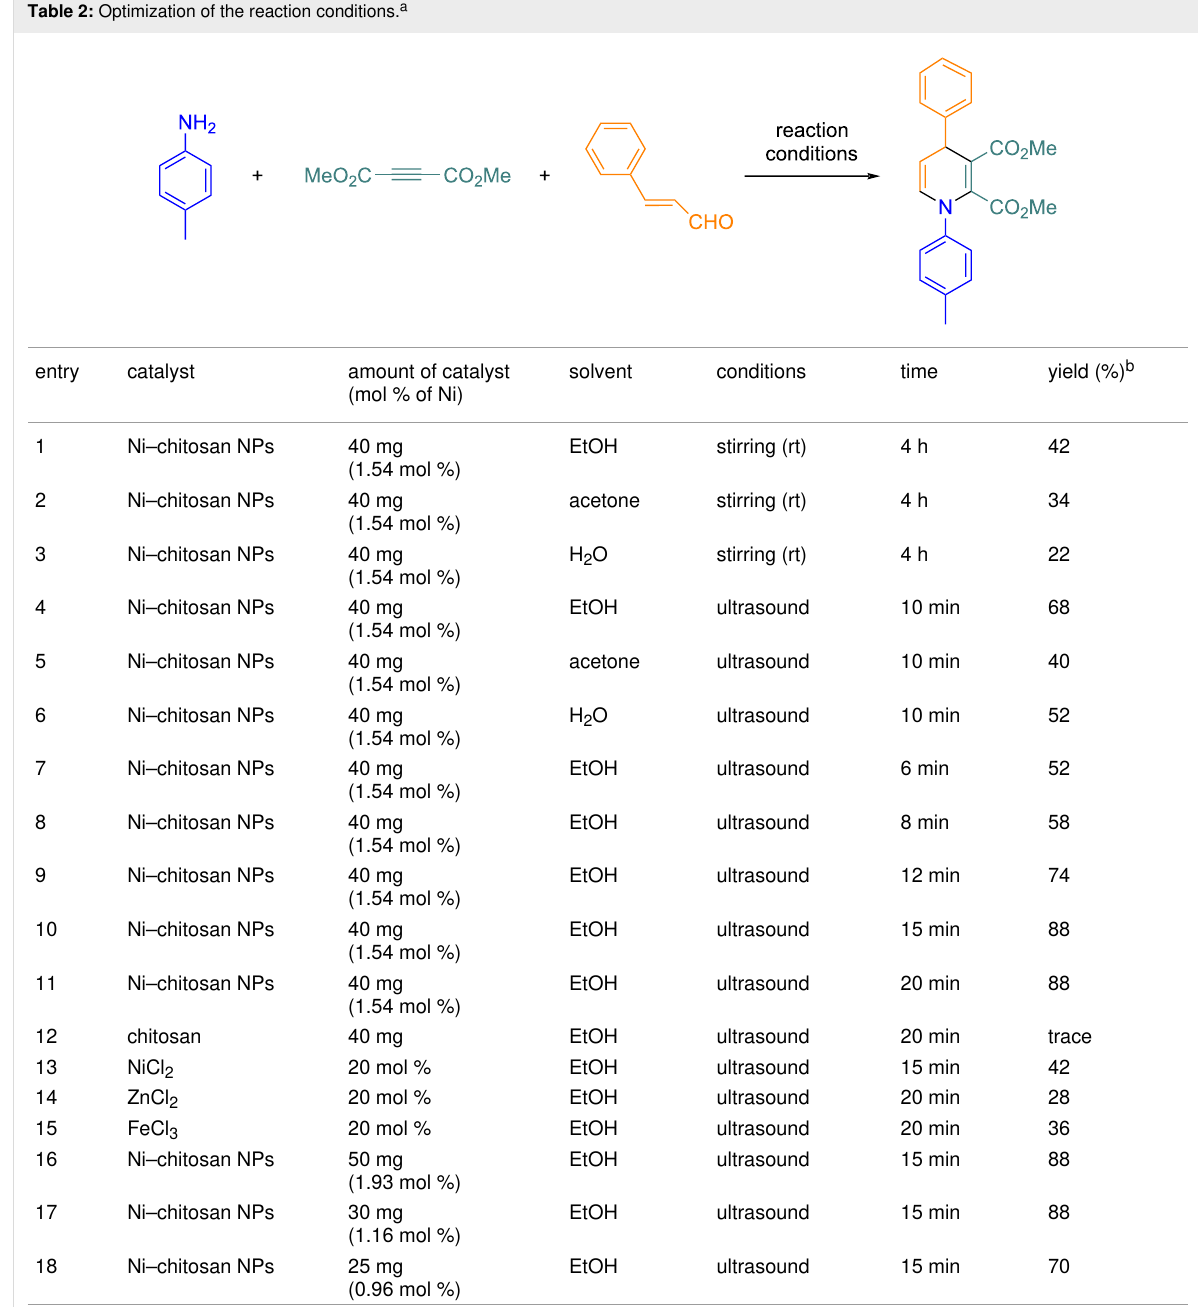
Table 2: Optimization of the reaction conditions.